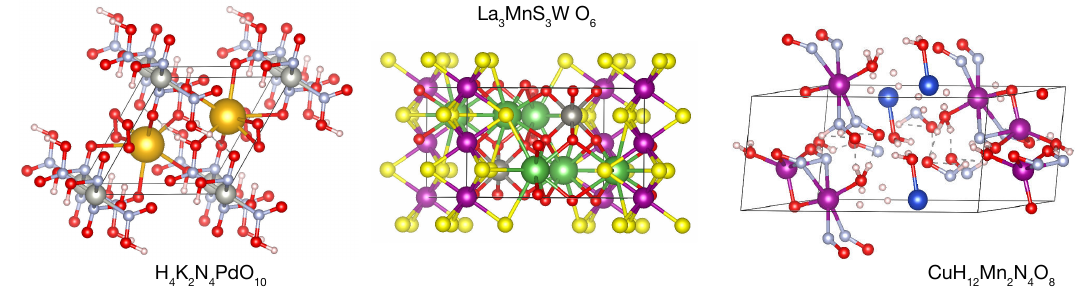
Figure 2. Crystal structures of quinary prototypes of half metals revealed in the HT